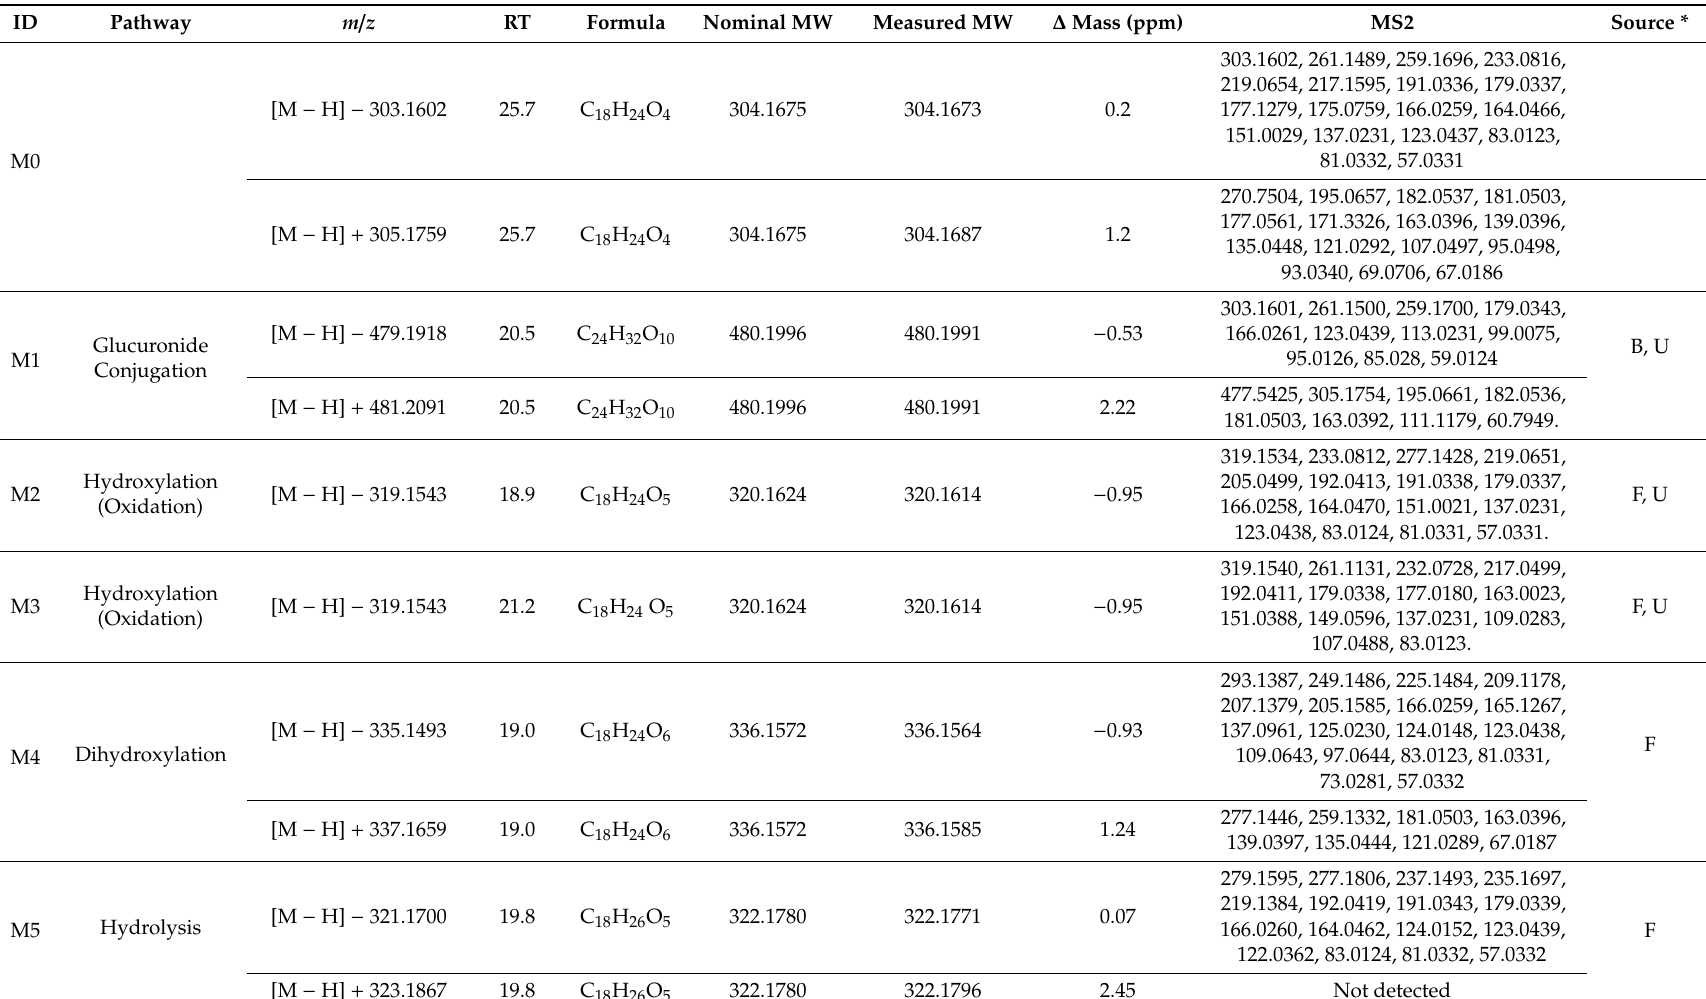
Table 4. Mass spectral characterization of tHGA and its metabolites in rat blood, urine and